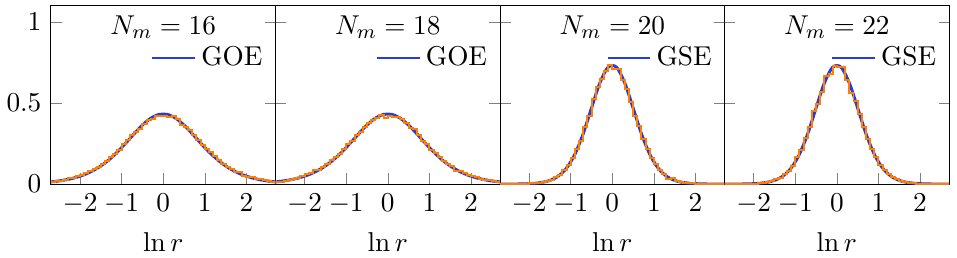
Figure 3 . Distribution of the ratio r of two consecutive level spacings in the N = 1 SYK model with ^ q = 5. The number of realizations used for averaging was 10 3 for N m = 16, 100 for N m = 18 and 22, and 200 for N m = 20. The blue lines are surmises for the RMT classes in table